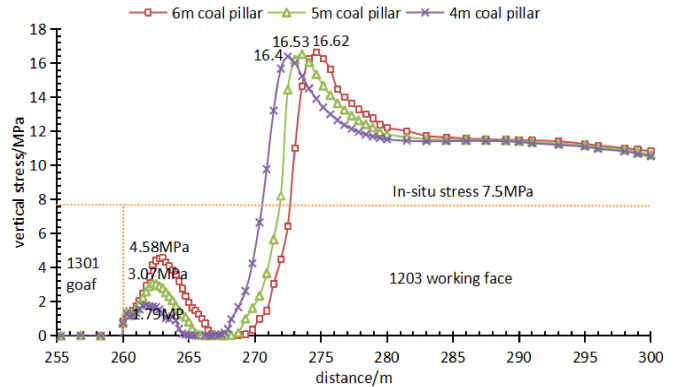
Figure 11. Diagram of the vertical stress distribution of the coal pillar of different